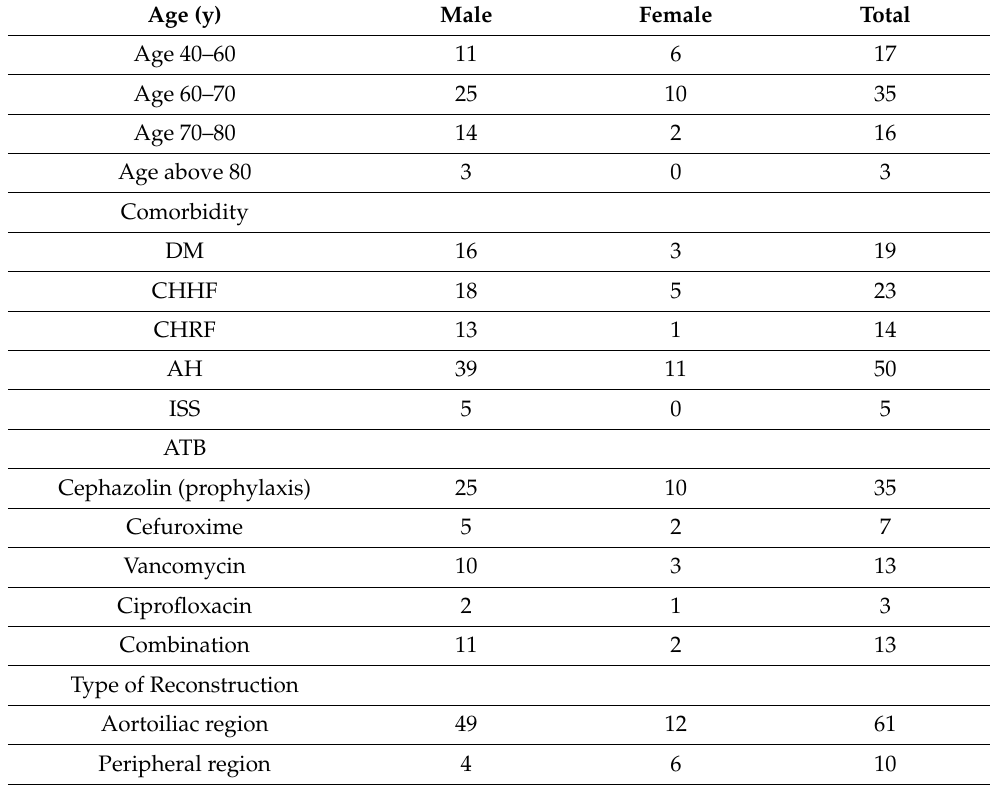
Table 1. Cohort of patients in the